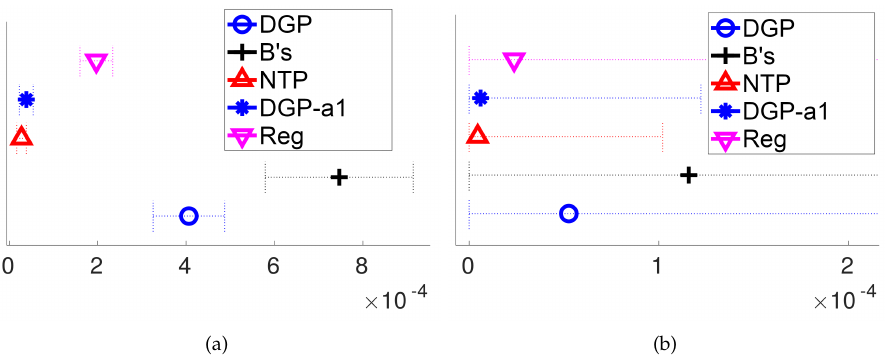
Figure A7. All scenarios produce a single behaviour for all methods both in ( a ) M 7 ( comp ) and ( b ) M 8 ( std − comp ). The magnitude of the measure is in the abscissa, in seconds.